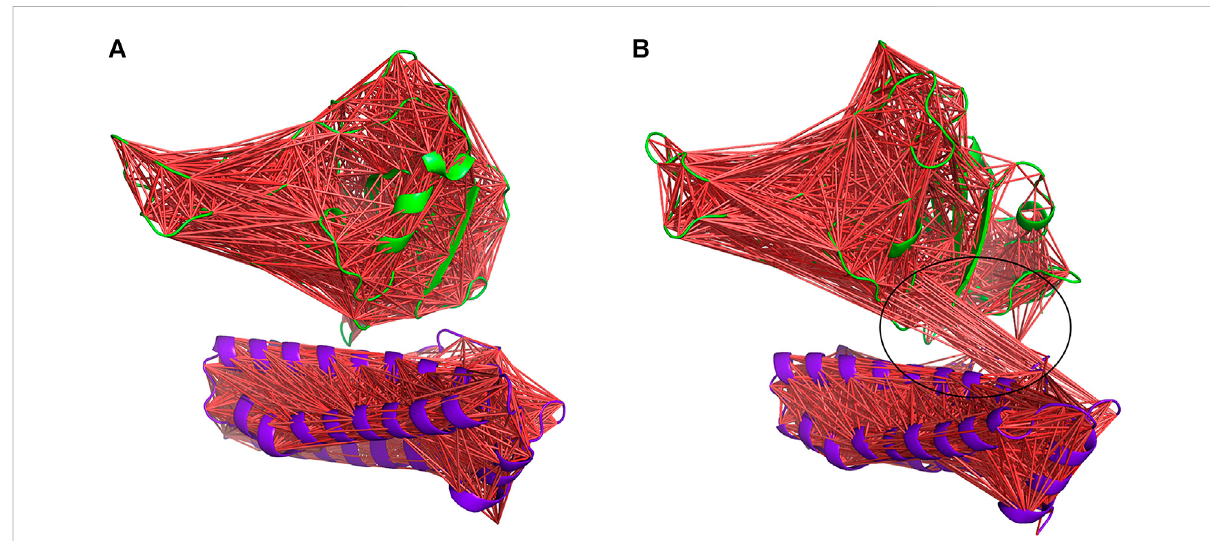
FIGURE 14 DCCM of gRBDfN and gmRBDfN is calculated over 100 ns MD simulations. gRBDfN and gmRBDfN are shown in (A) and (B) , respectively. Dark red lines show anti-correlated motions between RBD in green and ferritin in purple cartoons. Speci fi c anti-correlated motions between the ferritin and RBD are shown in the circle in picture (B)